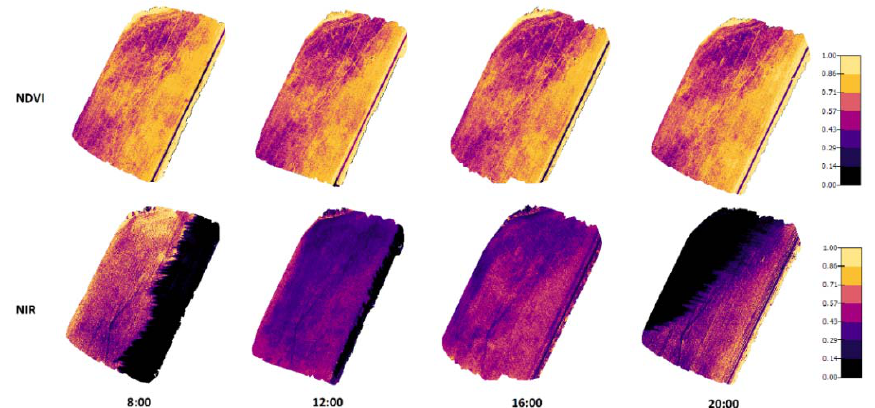
Figure 7. Orthomosaic maps for NDVI and NIR values in Koirasuo field at four different measurement times. The measurements were taken on 1 August 2020 when the crop growth stage for spring barley was 86 (Zadoks value).